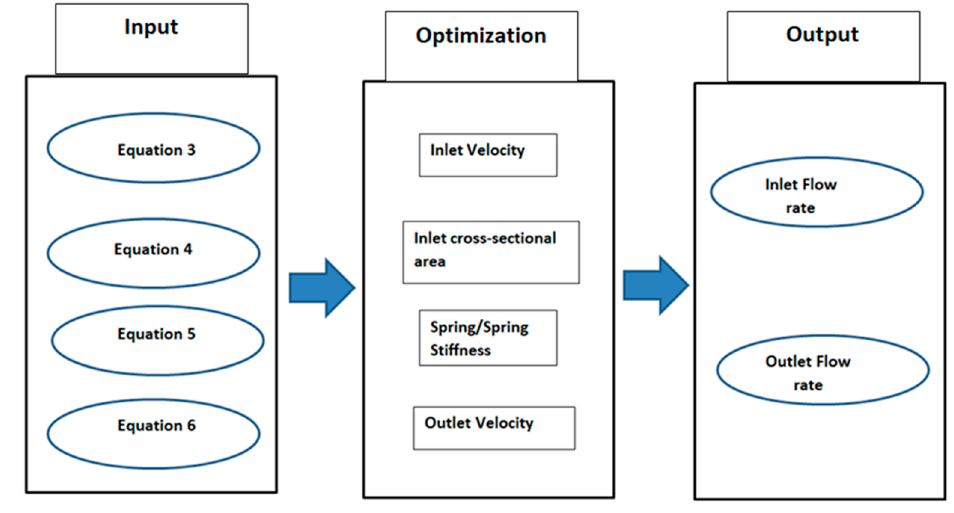
Figure 3. Optimization process for the buoy.